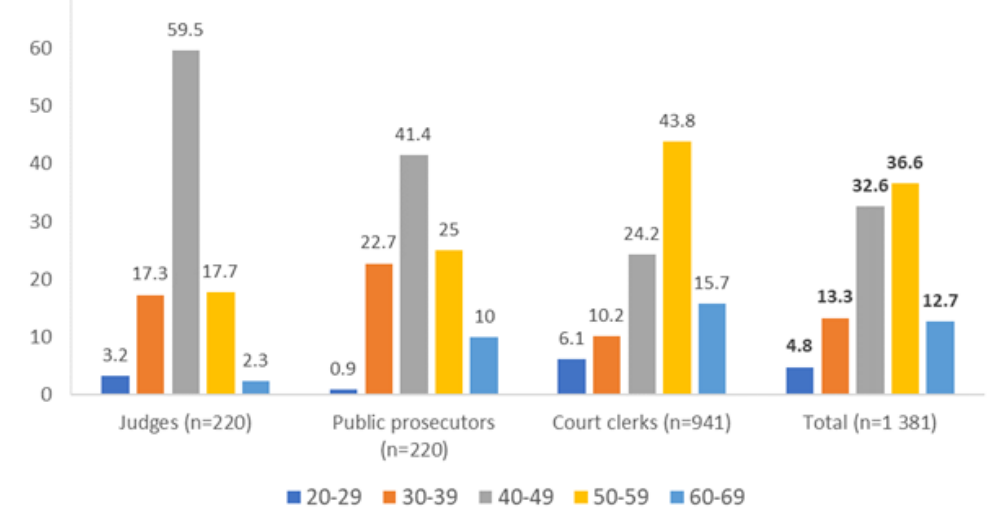
Figure 2: Age Groups by Judicial Professions and Total